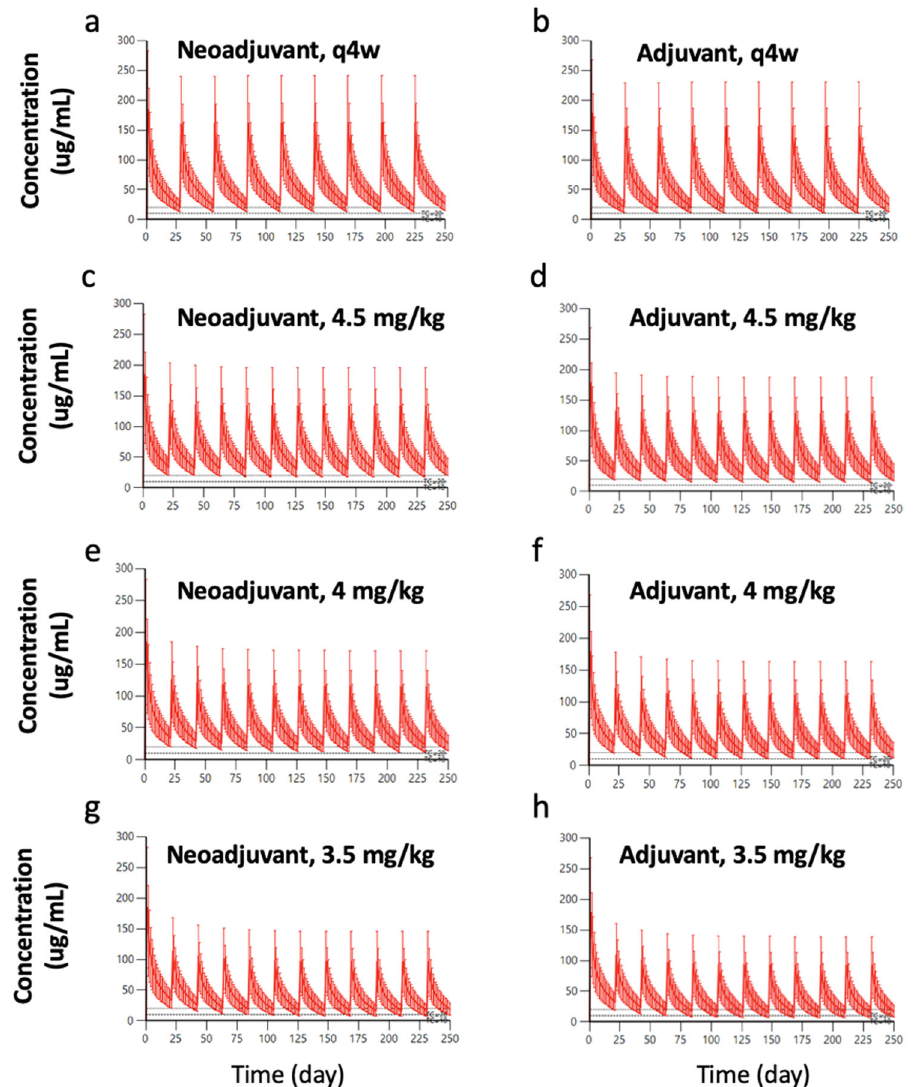
Fig. 2 Simulated concentration-time pro fi le for early HER2-positive breast cancer patients receiving interventional pharmacoeconomic dosing of trastuzumab. Less frequently every 4 weeks (Q4W) dosing schedule in the a neoadjuvant and b adjuvant settings. Every 3 weeks (Q3W) schedule in the c neoadjuvant setting with maintenance dose 4.5 mg/kg, d adjuvant setting with maintenance dose 4.5 mg/kg, e neoadjuvant setting with maintenance dose 4 mg/kg, f adjuvant setting with maintenance dose 4 mg/kg, g neoadjuvant setting with maintenance dose 3.5 mg/kg, and h adjuvant setting with maintenance dose 3.5 mg/kg. In all panels, the solid red line indicates median concentration, and the red shaded region represents 95% CI of the data. Upper dashed line represents concentration = 20 µg/mL. Lower dashed line represents target concentration = 10